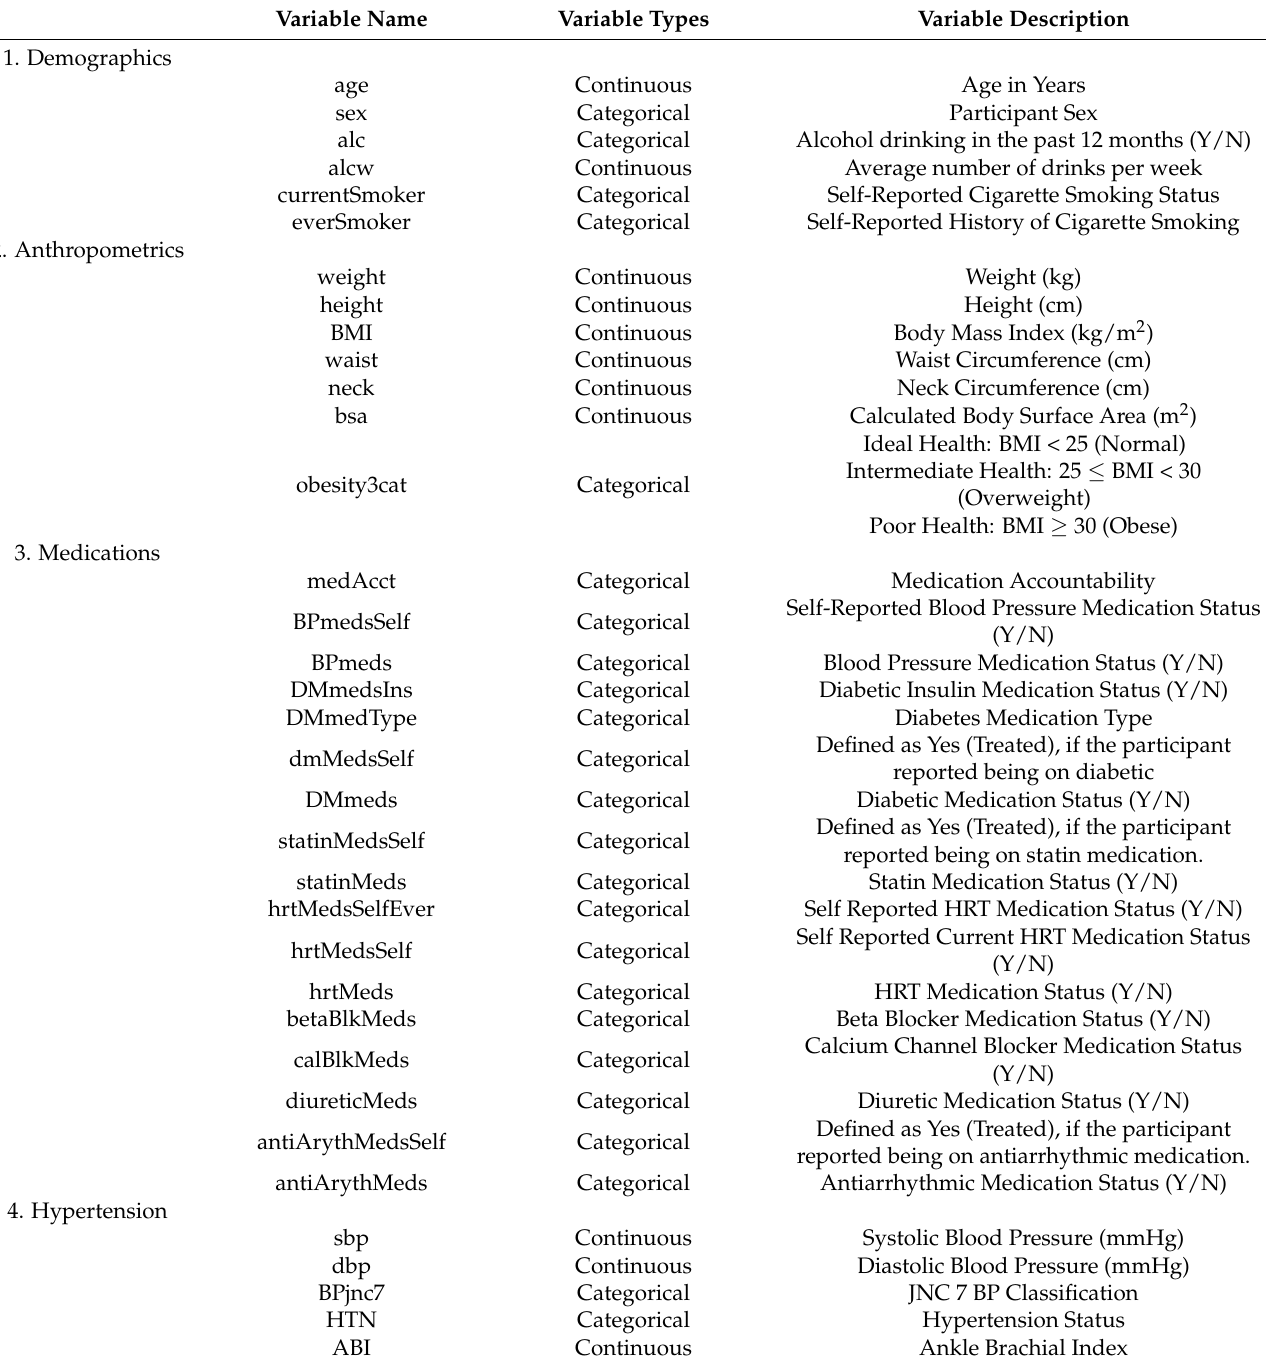
Table A1. Coding book for variables included in this